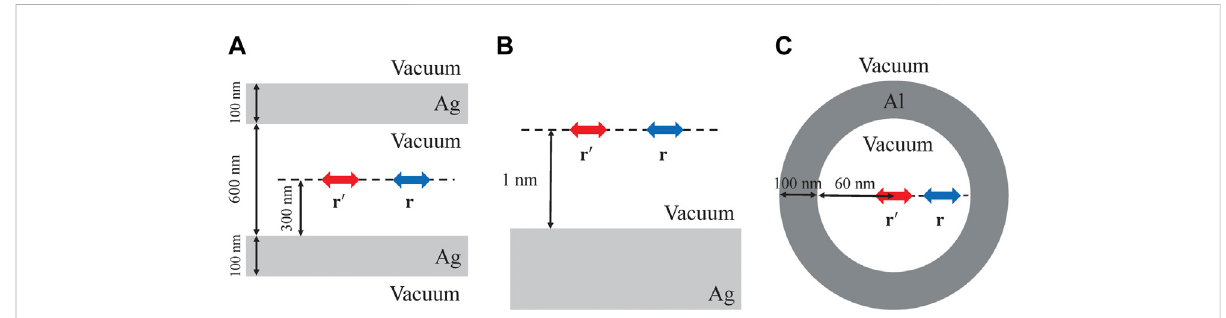
FIGURE 1 Schematic illustrations of molecules (A) inside a silver Fabry-Pérot cavity, (B) above a silver surface, and (C) inside a aluminum spherical cavity. (A) The silver Fabry-Pérot cavity comprises two silver plates in vacuum. The thickness of the silver plates are set to be 100 nm, and the distance betweentheplatesis600 nm.Themoleculesarelocated300 nmabovethelowersilverplate,withtheirtransitiondipolemomentsperpendicularto the cavity axis. (B) The distance between the molecules and the silver surface is 1 nm, and the transition dipole moments of the molecules are perpendicular to the normal direction of the silver surface. (C) The aluminum spherical cavity is composed of a hollow sphere in vacuum. The radius of the inner sphere and the thickness of the shell are set to be 60 and 100 nm, respectively. The molecules are inside the sphere, and we set one of themlocatedatthecenterofthesphere.Forsimplicity,wesetthatthetransitiondipolemomentsofthemoleculesinthethreesystemsarethesame (the magnitude is 1 Debye and the direction is